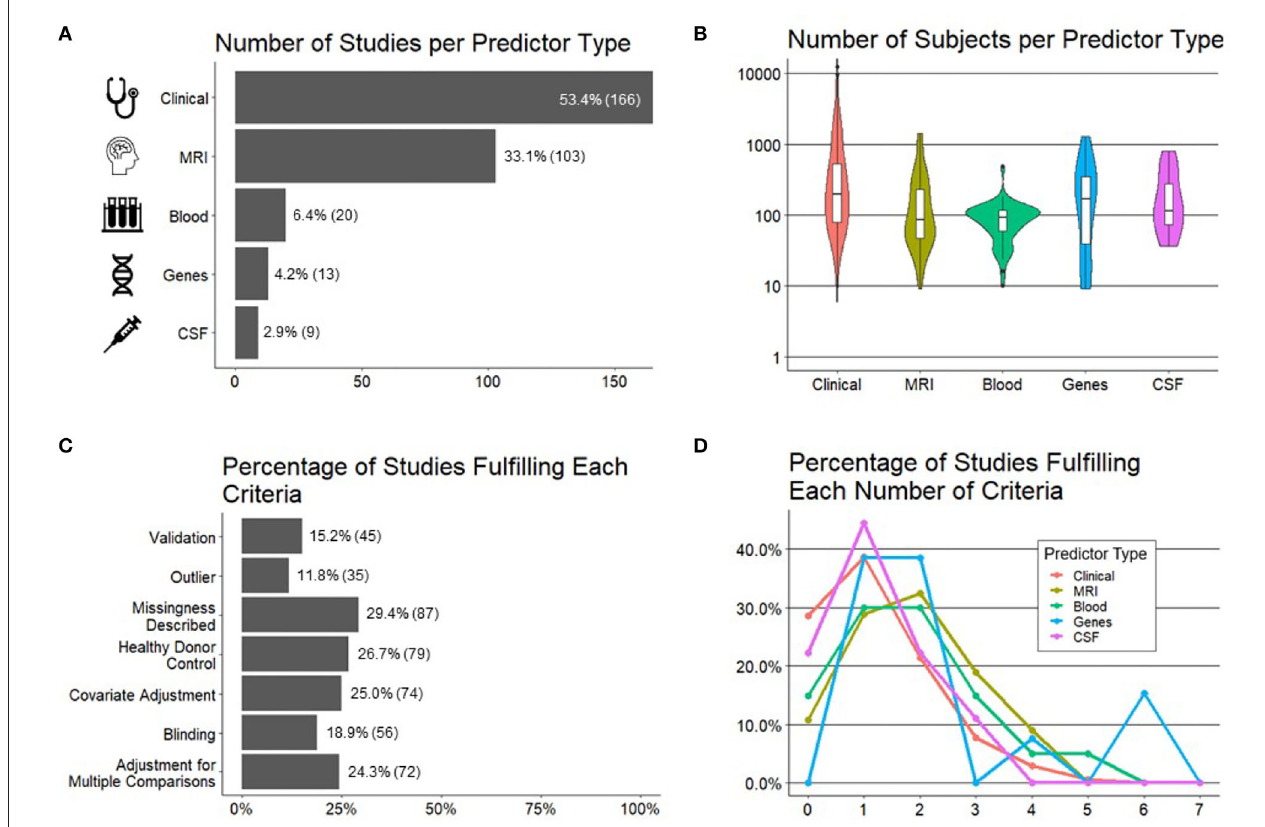
FIGURE 3 | Important characteristics of the studies reviewed. (A) Number of studies ( x -axis) per predictor type ( y -axis). (B) Number of subjects ( y -axis) by predictor type ( x -axis). (C) Percentage of studies ( x -axis; number of studies in parentheses) fulfilling each preselected criteria of experimental design/technical quality of the study ( y -axis). (D) Percentage of studies ( y -axis) per each predictor type fulfilling a number of technical criteria ( x